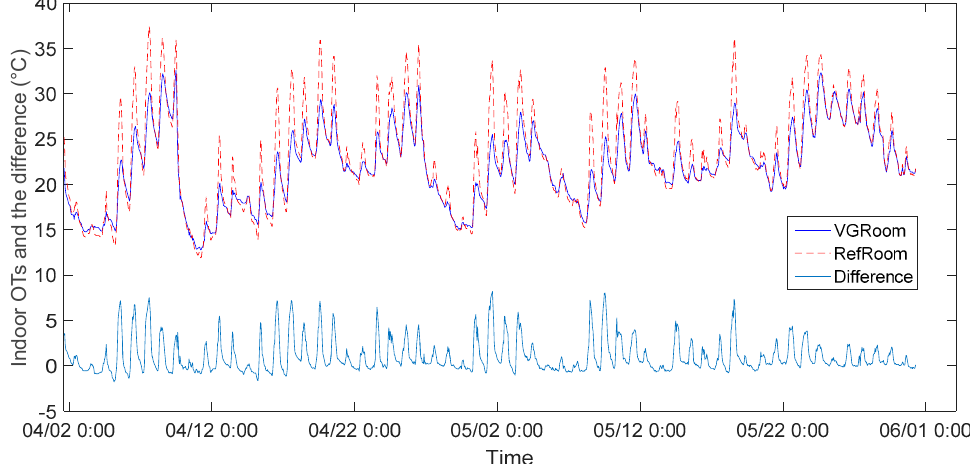
Figure 14. Indoor OTs for two experiment rooms and the differences.